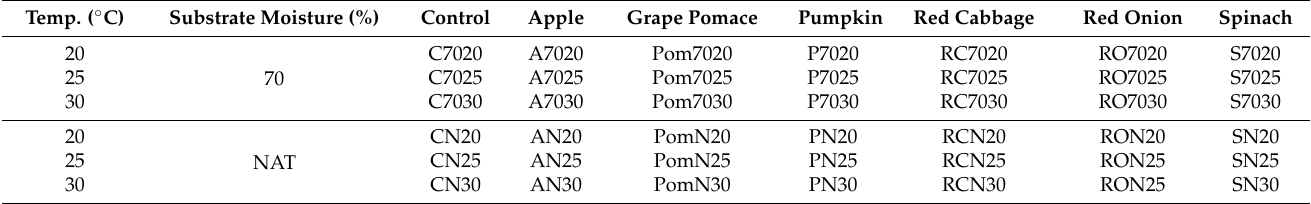
Table 2. Experimental design and codification of groups of samples for the